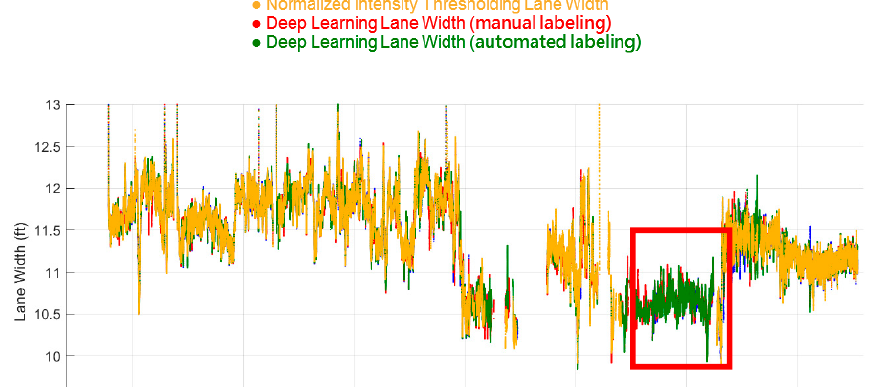
Figure 28. Estimated lane width values in ( a ) lane 1 and ( b ) lane 2 for dataset 1.